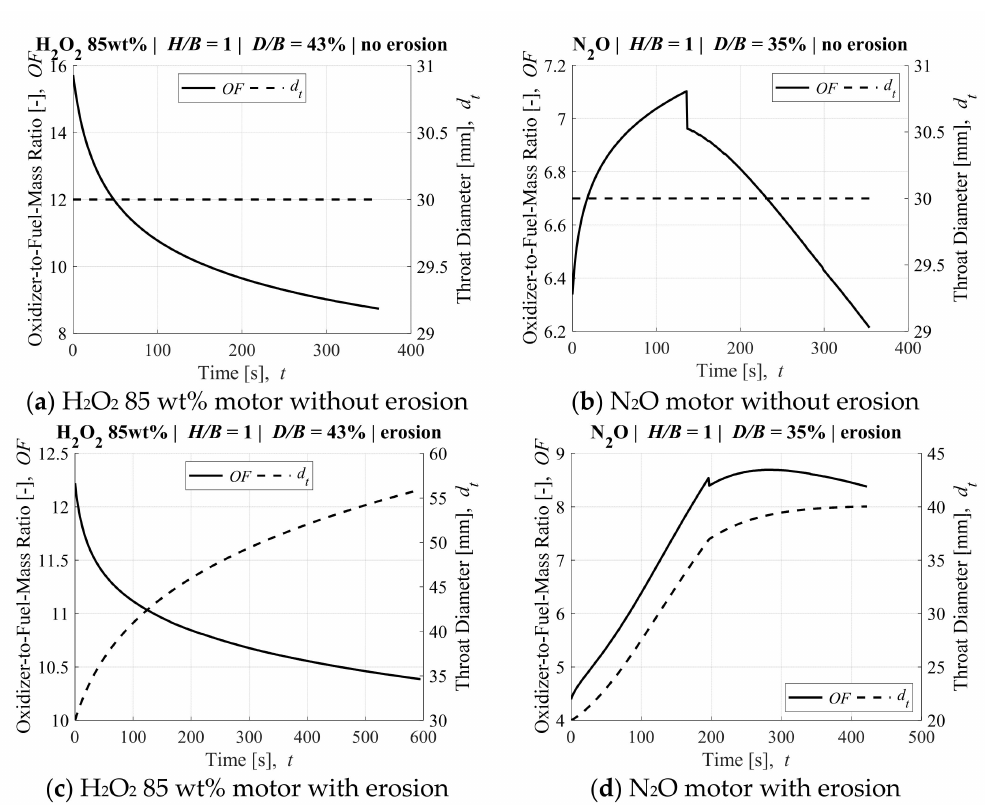
Figure 18. Comparison of O / F and throat diameter histories.